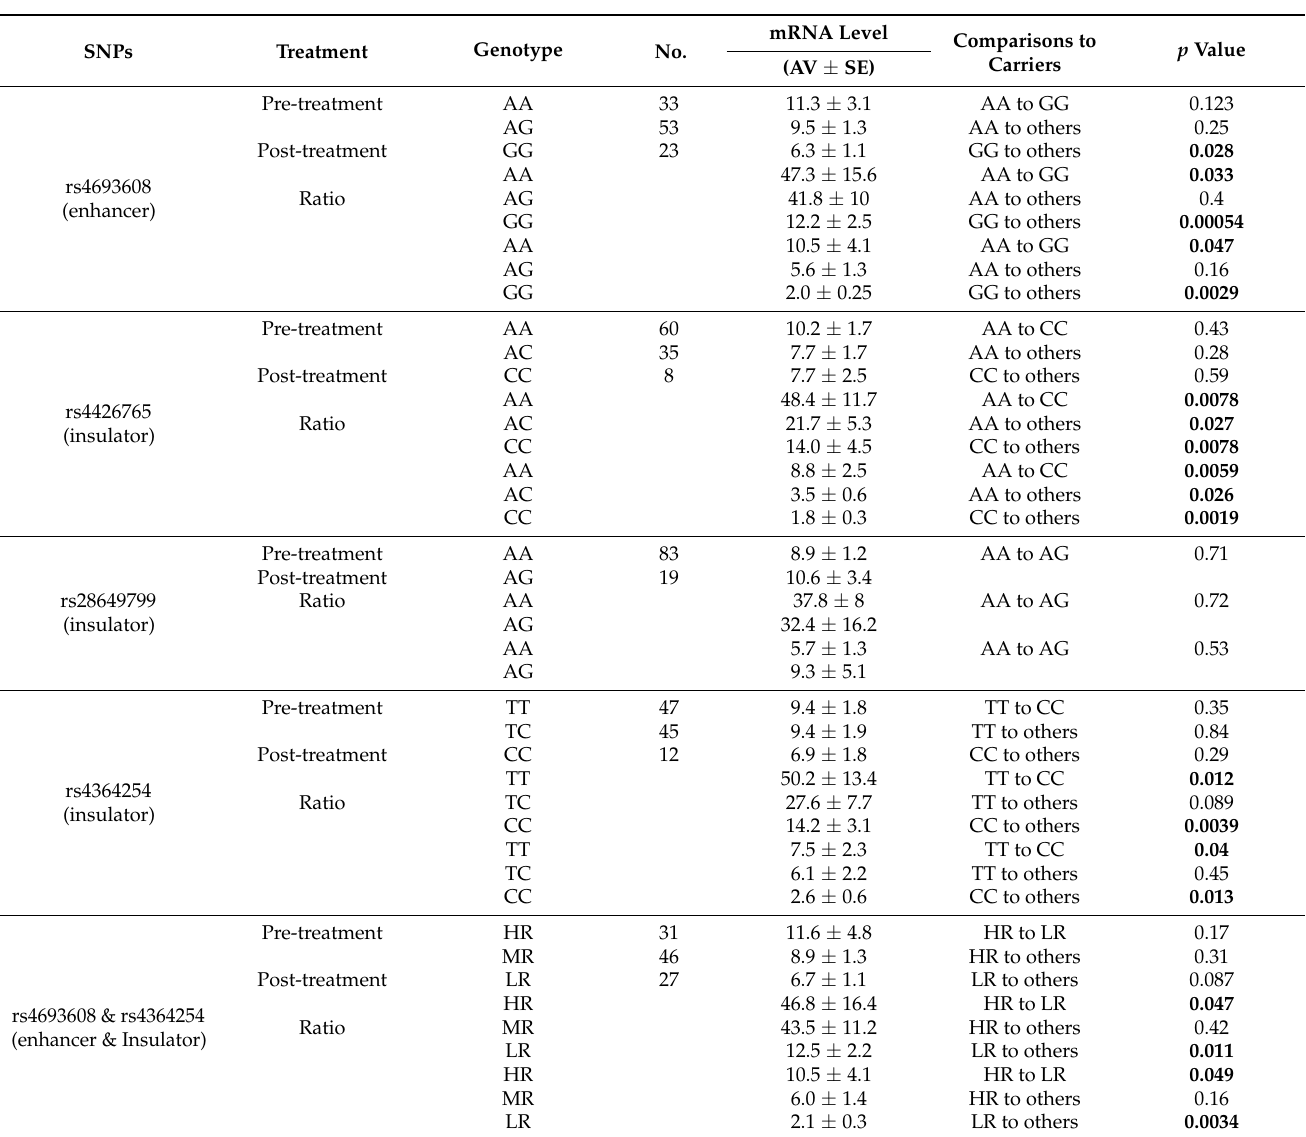
Table 4. Association between enhancer and insulator HPSE gene SNPs and heparanase mRNA expression levels in MNCs from healthy individuals before and after LPS